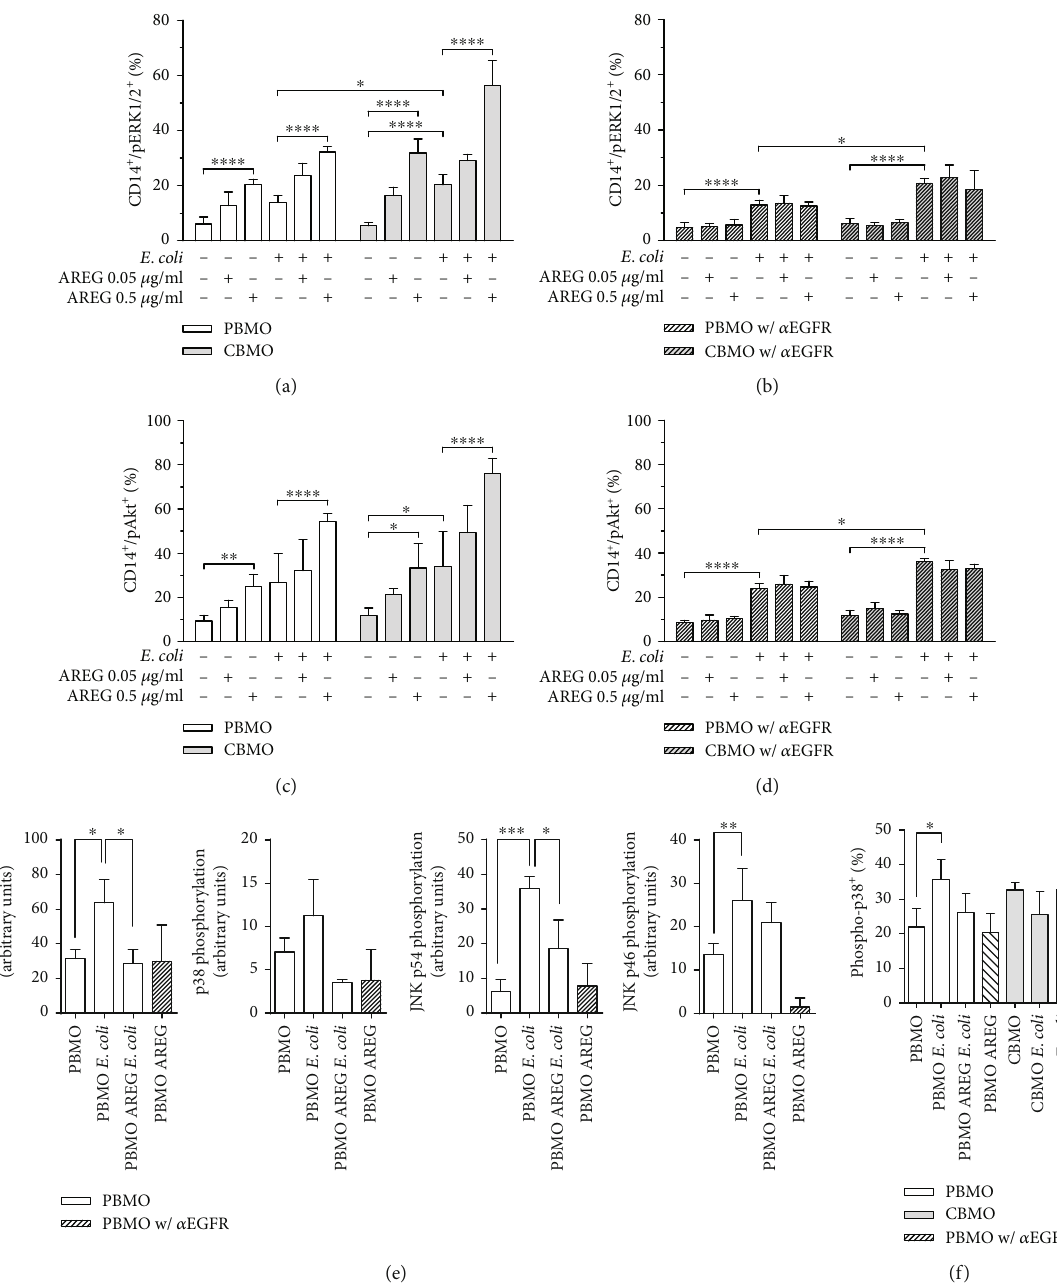
Figure 1: MAPK and Akt phosphorylation — levels of activated monocytes and intracellular protein levels in PBMO and CMBO in response to infection, AREG stimulation, and inhibition of EGFR. Isolated monocytes were infected with E. coli , extracellular bacteria were removed, and the cells were cultivated for 24 h in medium supplemented with antibiotics. 1 h prior to infection, AREG stimulation and EGFR inhibitor treatment were started and maintained during the entire cultivation period. Quanti fi cation was performed by fl ow cytometry (a – d, f). (a) Detection of pERK1/2 in PBMO and CBMO in response to infection and AREG stimulation. AREG stimulation dose-dependently induces phosphorylation in all settings. ERK1/2 phosphorylation is induced in response to E. coli infection ( n = 5 ). (b) E ff ect of EGFR inhibition on pERK1/2 in PBMO and CBMO in response to infection and AREG stimulation. Inhibition of EGFR abolishes the AREG-dependent phosphorylation ( n = 4 ). (c) Detection of pAkt in PBMO and CBMO in response to infection and AREG stimulation. AREG stimulation dose-dependently increases pAkt levels in all settings. Akt phosphorylation is induced in response to E. coli infection ( n = 5 ). (d) E ff ect of EGFR inhibition on pAkt in PBMO and CBMO in response to infection and AREG stimulation. Inhibition of EGFR abolishes the AREG- dependent phosphorylation ( n = 4 ). Quanti fi cation of immunoblot signals on which the indicated MAPK were detected ((e); n = 3 ). Detection of pp38 in PBMO and CBMO in response to infection and AREG stimulation ((f); n = 4 ). Data are shown as means + SD . Statistical signi fi cance was analyzed using two-way ANOVA with Bonferroni ’ s multiple comparisons test ( ∗ p < 0 : 05 ; ∗∗ p < 0 : 01 ; and ∗∗∗∗ p < 0 : 001 ). In (e, f), error bars detail results of unpaired Student ’ s t -test with Welch correction ( ∗ p < 0 : 05 ; ∗∗∗ p < 0 : 005